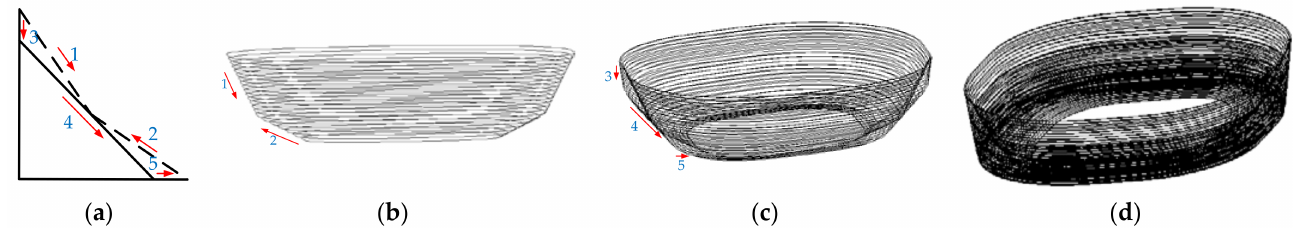
Figure 11. The second stage forming: ( a ) the toolpath schematic of the first two layers; ( b ) toolpath of the first layer; ( c ) toolpath of the second layer; and ( d ) the second stage forming